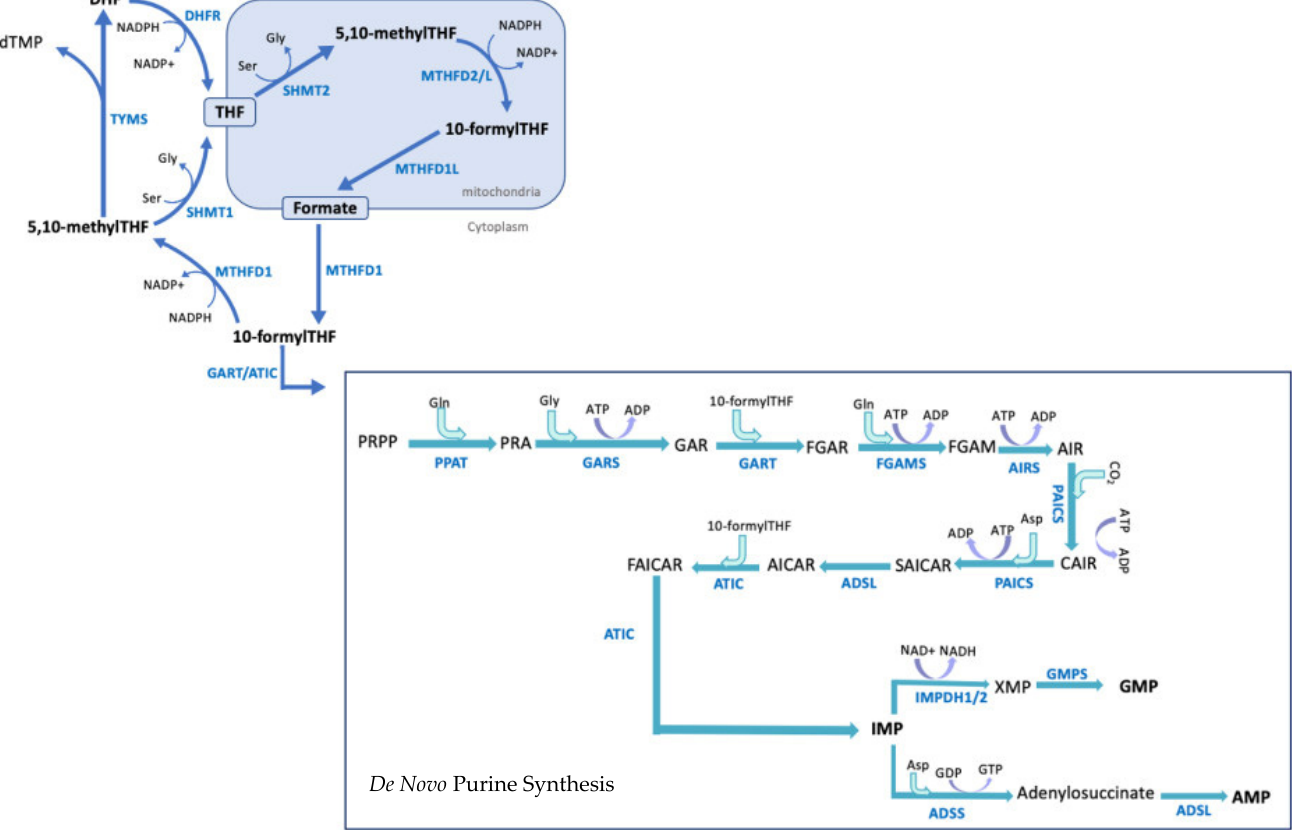
Figure 1. One-carbon-mediated de novo purine synthesis. Dietary folate is reduced to dihydrofolate (DHF) and subsequently tetrahydrofolate (THF) by dihydrofolate reductase (DHFR). THF is acted on by a series of enzymes in the mitochondria, which add methyl groups to THF, allowing it to act as the initial 1-C carrier required for a variety of biosynthesis processes. 10-Formyl-THF is produced in the mitochondria from the reduction of 5,10-methyl-THF by methylene tetrahydrofolate dehydrogenase 2 (MHFD2/L). 10-Formyl-THF is then used in de novo purine synthesis as a carbon donor. The purine ring is built directly onto the 5-phosphoribose-1-pyrophosphate (PRPP) backbone during de novo purine synthesis, and requires the substrates glutamine, glycine, bicarbonate and 10-formyl-THF. De novo purine synthesis is a 10-step cy- tosolic reaction that results in the production of inosine monophosphate (IMP). IMP is further converted into guanosine monophosphate (GMP) via the activity of the enzymes inosine monophosphate dehydrogenase (IMPDH1) and guanosine monosphosphate synthetase (GMPS), or adenosine monophosphate (AMP) via the activity of the enzyme adenylosuccinate synthase (ADSS) and adenylosuccinate lyase (ADSL). TYMS: thymidylate synthase; dTMP: deoxythymidine monophos- phate; SHMT1/2: serine hydroxymethyltrasnferase 1/2; PPAT: phosphoribosyl pyrophosphate amidotransferase; GART: glycinamide ribonucleotide transformylase; MTHFD1L: Methylenetetrahydrofolate Dehydrogenase (NADP+-Dependent) 1 Like; FGAMS: formylglycinamidine ribonucleotide synthase (FGAMS); PAICS: phosphoribosylaminoimidazole carboxy- lase; AICAR: 5-Aminoimidazole carboxamide ribonucleotide; ATIC: 5-aminoimidazole-4-carboxamide ribonucleotide formyltransferase/IMP cyclohydrolase; XMP: xanthosine